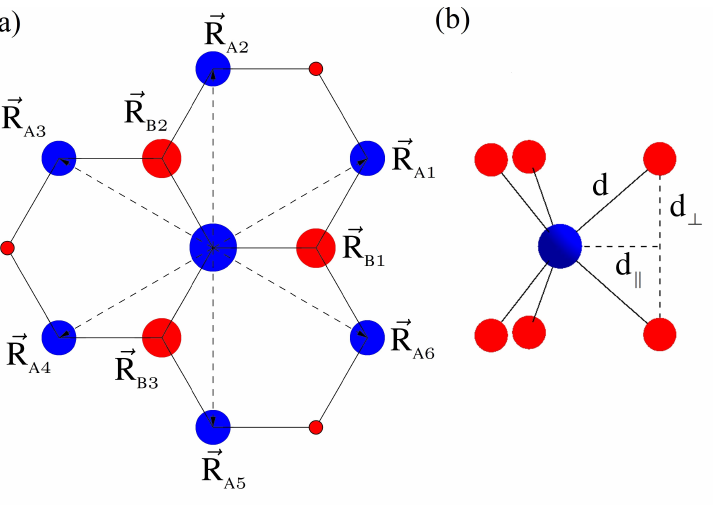
Figure 2. ( a ) Top view of the structure of MX 2 in the 2H phase: metal atoms are denoted by blue dots, and chalcogen by red ones. ( b ) Side view of MX 2 , showing that the atoms are organized into three layers, central metal and two chalcogen, with structural constants parametrized by d (cid:107) and d ⊥ .